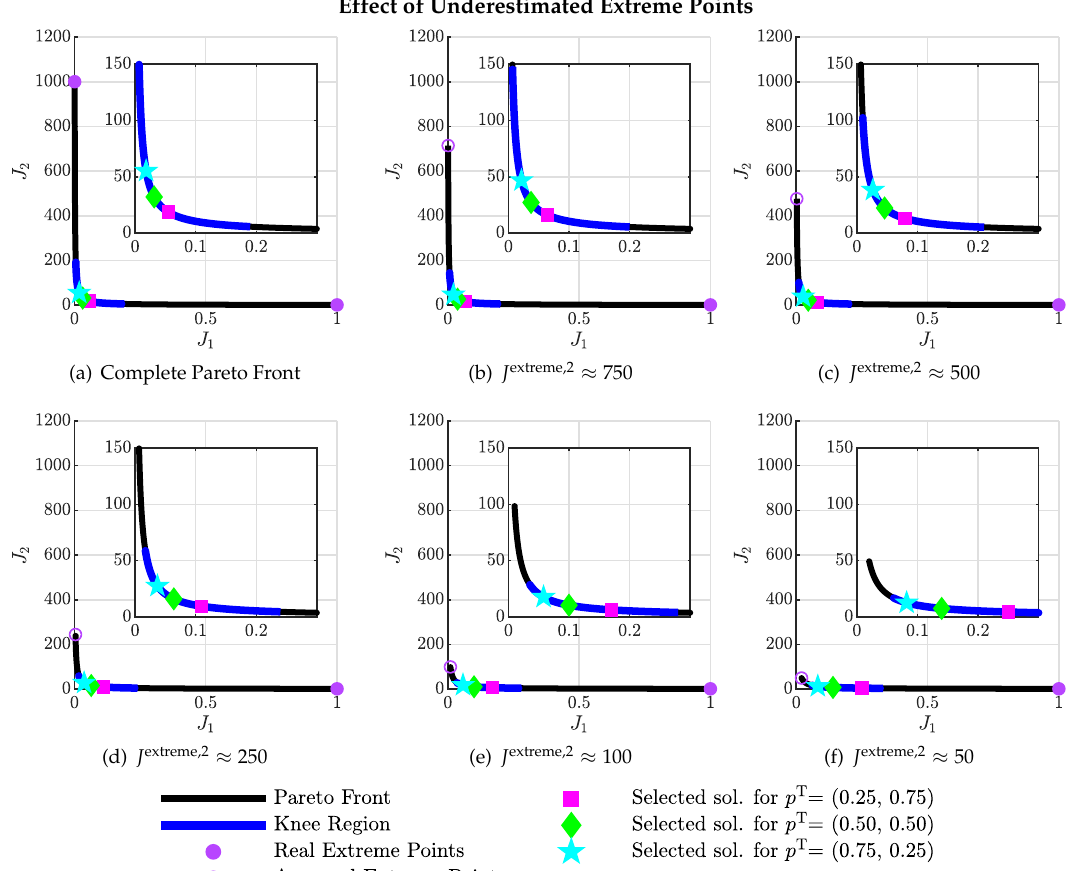
Figure 6. Comparison of the knee regions and selections for the artifical Pareto front from (14) for various underestimated J extreme,2 and three different preference settings. r lim = 0.85. As expected, both the knee region and the final decision shift to the right, i.e., to higher values of J 1 , for lower J extreme,2 . The shift is more severe for higher preferences on J 2 (see magenta square). ( a ) Complete Pareto front with J extreme,2 = 1000.50, ( b – f ) incomplete Pareto fronts with underestimated J extreme,2 from 750 to